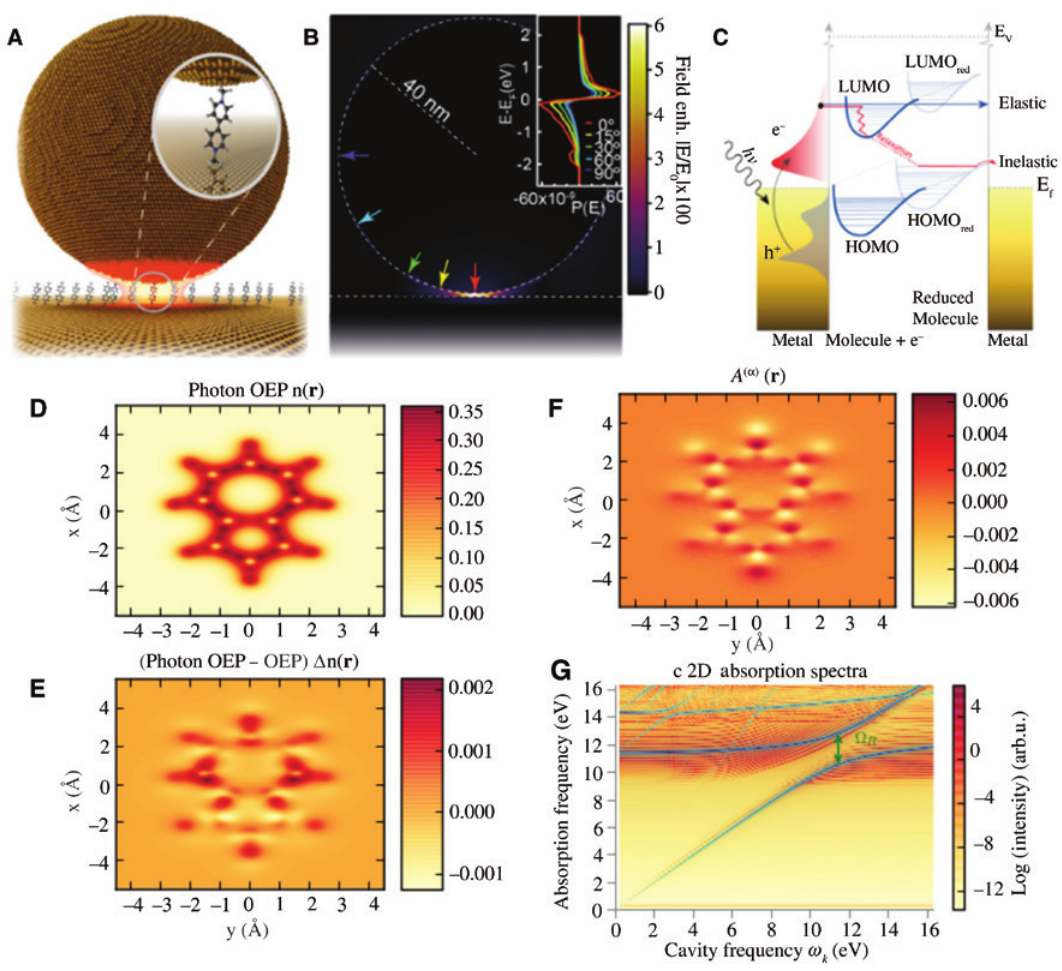
Figure 6: Novel concepts in strong light-matter coupling. (A) Chemical molecules in plasmonic hotspots [17]. (B and C) Driving chemical reactions by hot carrier generation [17]. (D) Electron density of an azulene molecule in an optical cavity [154]. (E) Changes of the ground-state density under strong light-matter coupling calculated within the framework of QEDFT [154]. (F) New light-matter correlation functions accessible with QEDFT [154]. (G) Absorption spectra for hydrogen dimer for different cavity frequencies ω [40]. (A–C) Adapted with permission from Ref. [17]. (D–F) Adapted with permission from Ref. [154]. (G) Adapted with permission from Ref. [40] (© 2018 Springer